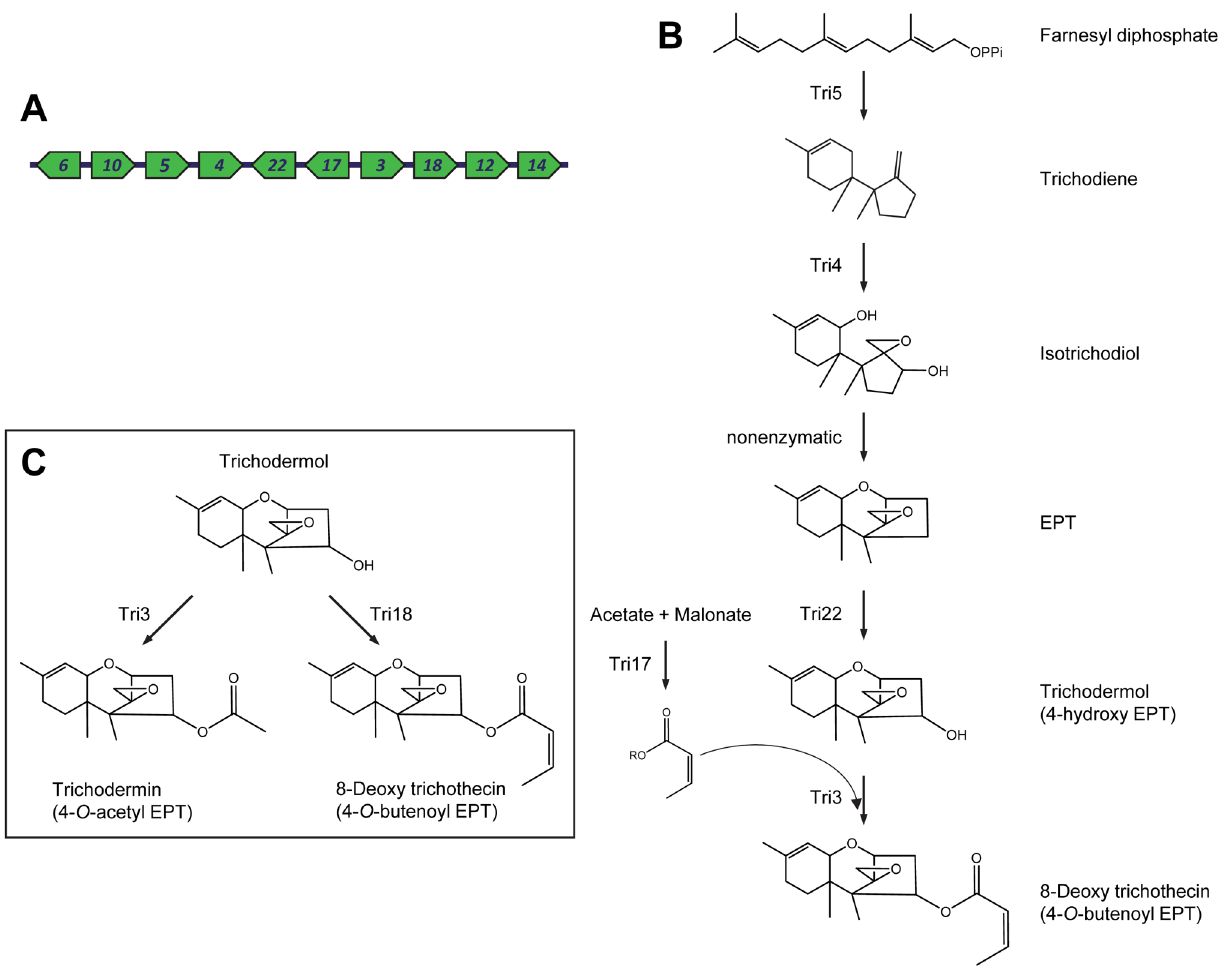
Fig 12. ( A ) Proposed ancestral TRI cluster based on the distribution of TRI genes among fungi examined in the current study. ( B ) Proposed ancestral trichothecene biosynthetic pathway based on inferred gene content of the ancestral TRI cluster and knowledge of TRI gene functions. ( C ) The presence of two acetyl/acyl transferase genes in the proposed ancestral cluster raises the possibility of a branch at the end of the ancestral pathway that would result in the formation of two trichothecene analogs: 4-acetyl EPT and 4-butenoyl EPT.